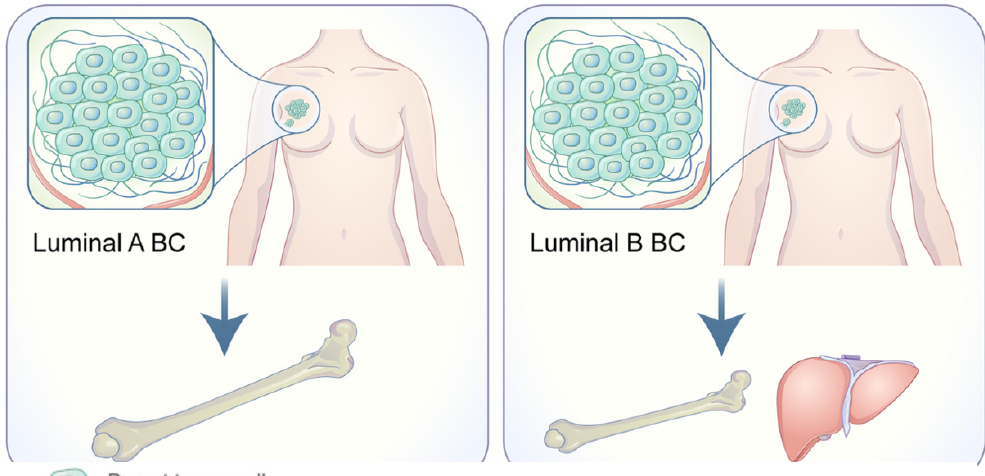
Figure 3. Adapted from Wang C, Xu K, Wang R. Heterogeneity of BCSCs contributes to the metastatic organotropism of breast cancer. J. Exp. Clin. Cancer Res. 2021, 40, 370 (2021). http://doi.org/10.1186/s13046-021-02164-6 [25,75]. http://creativecommons.org/licenses/by/4.0/, accessed 2 May 2022.